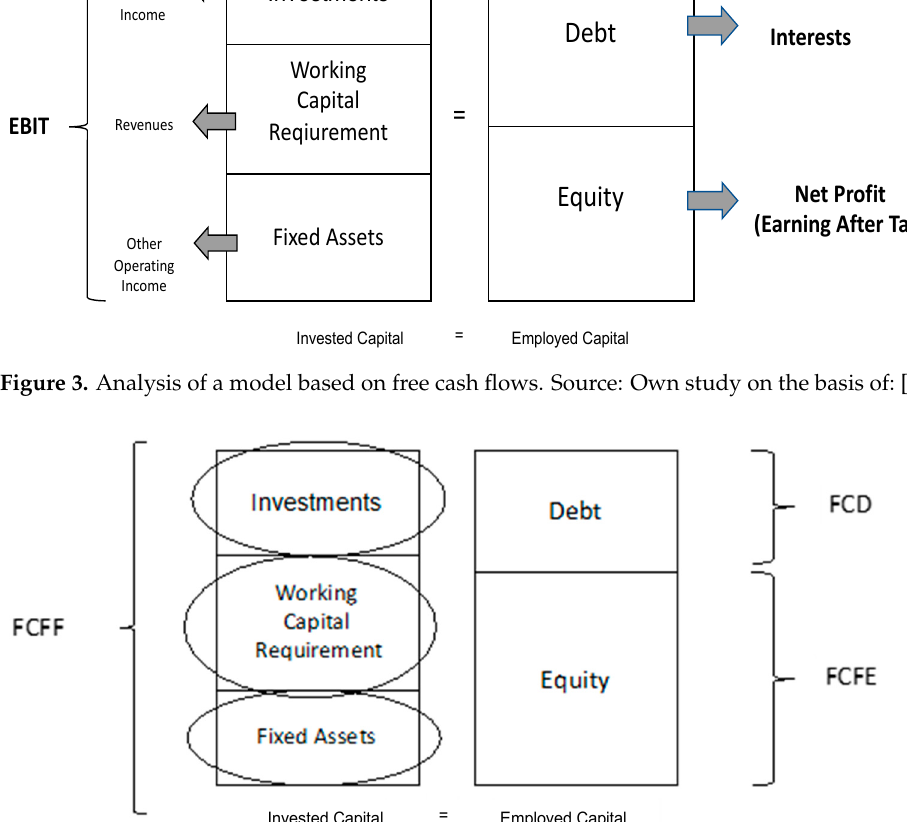
Figure 4. Linking decision-making areas to cash flow. Source: Own study on the basis of: [50]. Legend: FCFF—Free Cash Flow to Firm; FCFE—Free Cash Flow to Equity; FCD—Free Cash Flow to Debt